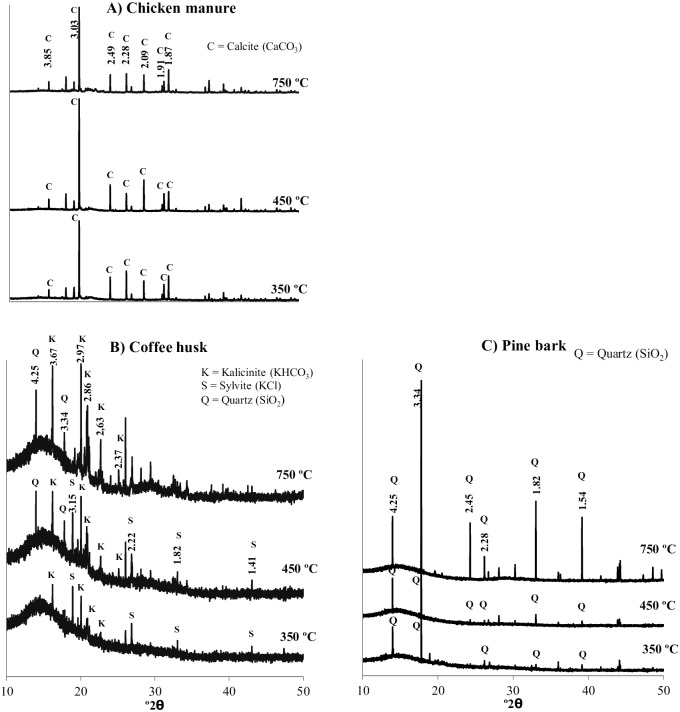
X-ray diffraction spectra of biochars pyrolized at different temperatures (350, 450 and 750°C).(A) Chicken manure biochar. (B) Coffee husk biochar. (C) Pine bark biochar.